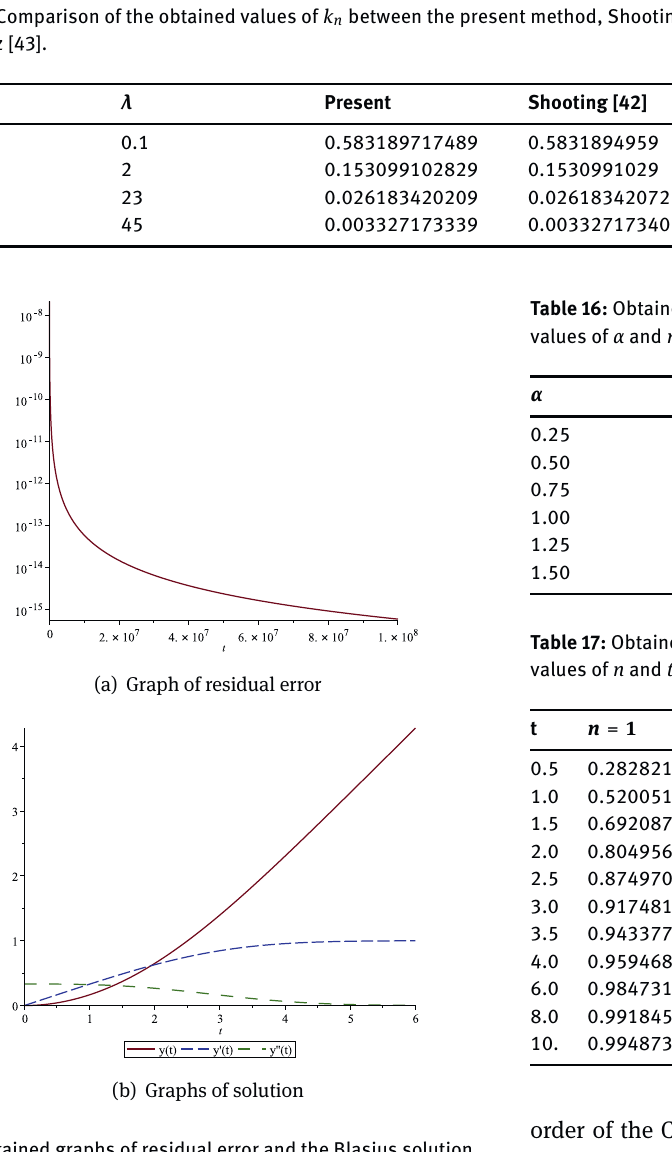
Fig. 5: Obtained graphs of residual error and the Blasius solution. Table 15: Obtained values of k 2 by the present method for various values of m and α = 0.50